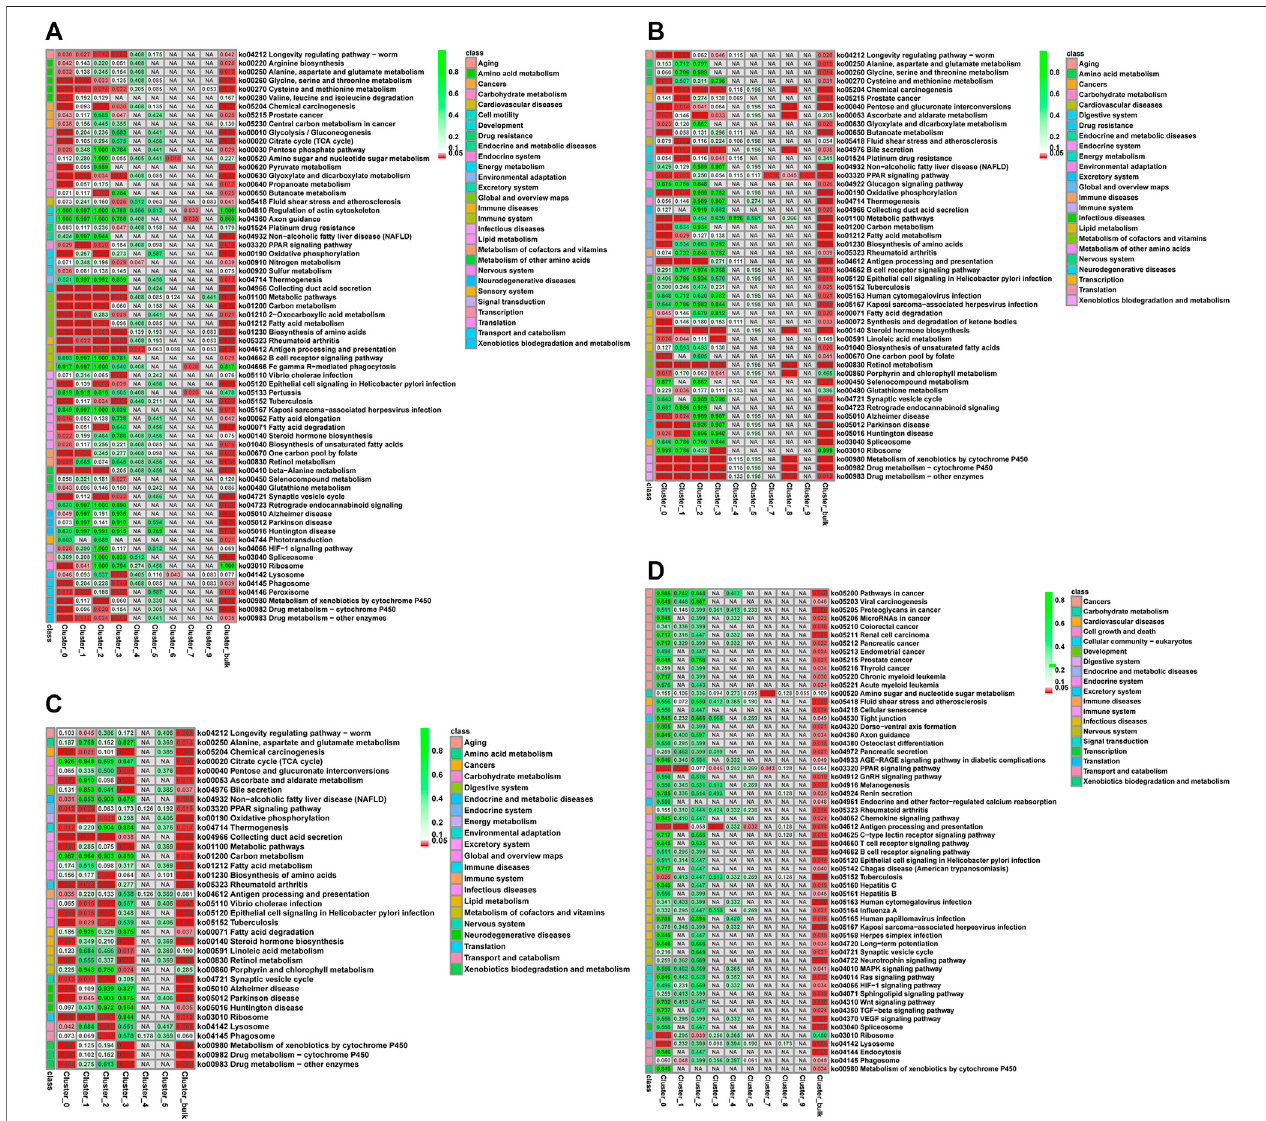
FIGURE4| Q-valueheatmapsofKEGGpathwaysassociatedwiththegenesdifferentiallyexpressedbetweencold-tolerantandcommon Litopenaeusvannamei at 10 ° C and 28 ° C across all cell clusters (Total) and in individual cell clusters (0 – 9). (A) common at 28 ° C versus common at 10 ° C, (B) cold-tolerant at 28 ° C versus cold- tolerantat 10 ° C, (C) common at 10 ° Cversuscold-tolerantat 10 ° C, and (D) common at 28 ° Cversus cold-tolerantat 28 ° C. Q-values(i.e., p -valuescorrectedfor the false discoveryrate)areshownincells:cellswhereQ ≤ 0.05areshowninred;cellswhereQ > 0.05areshowningreen;cellsnotcorrespondingtodifferentialexpression are shown in grey. Corresponding KEGG signaling pathways are shown in the leftmost column of each